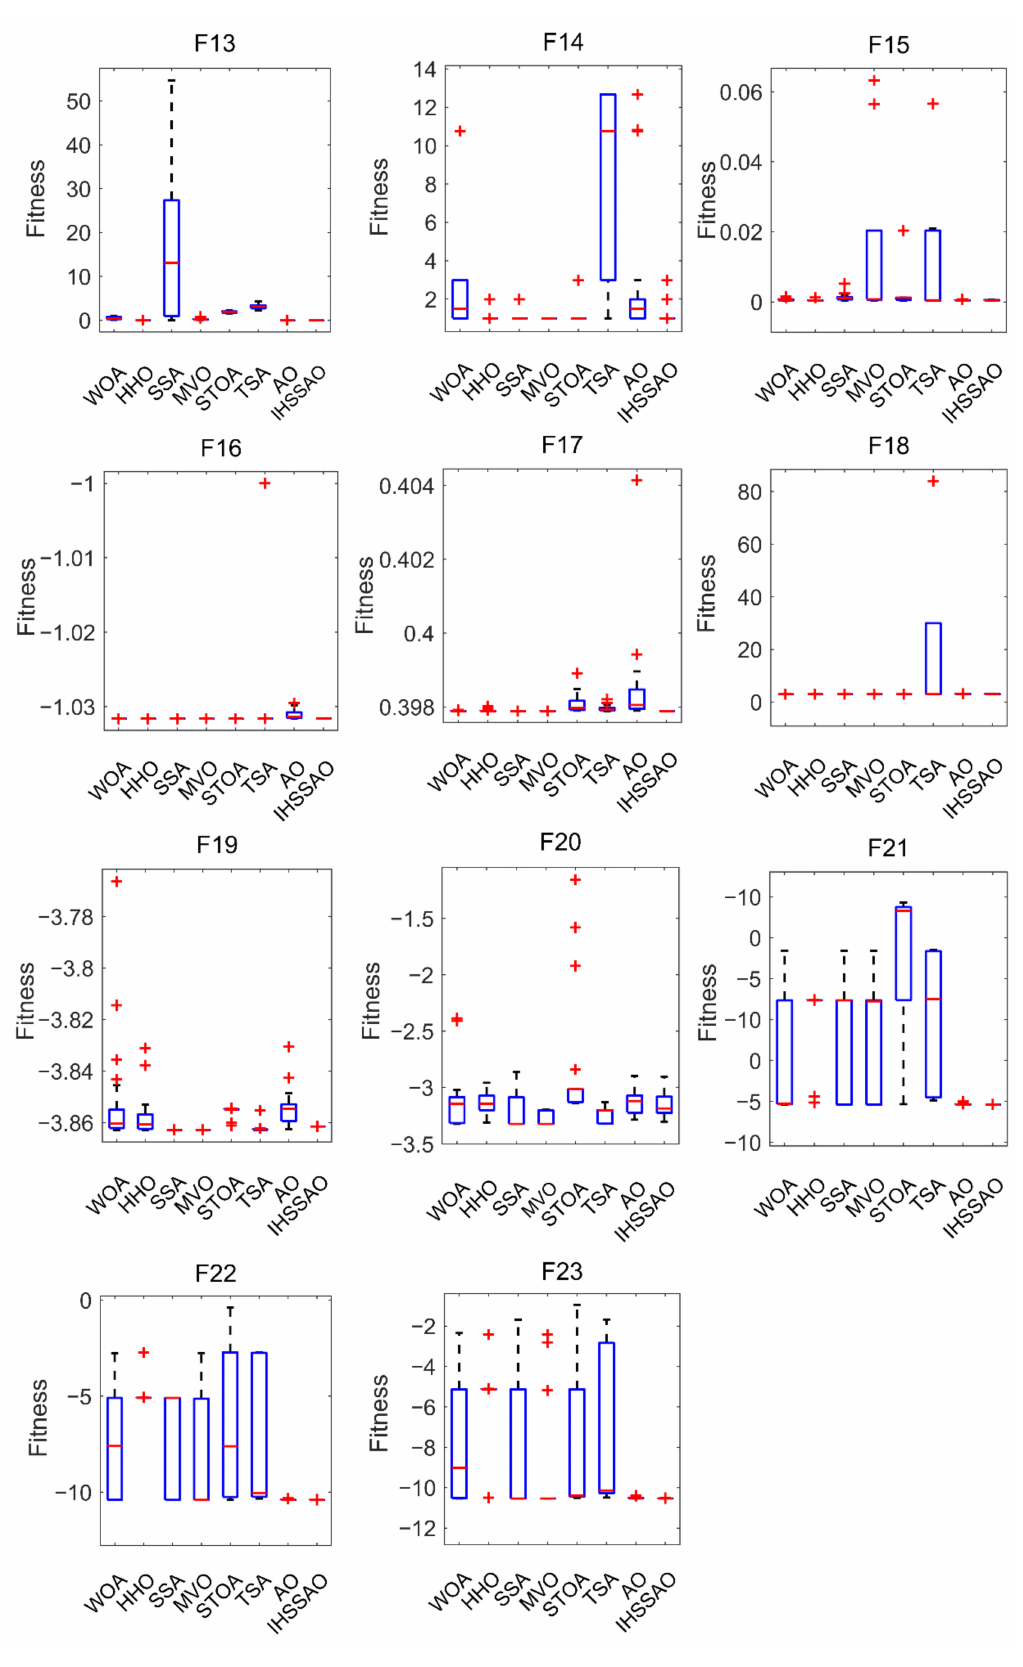
Figure 6. Boxplot of IHSSAO and other different algorithms on 23 benchmark